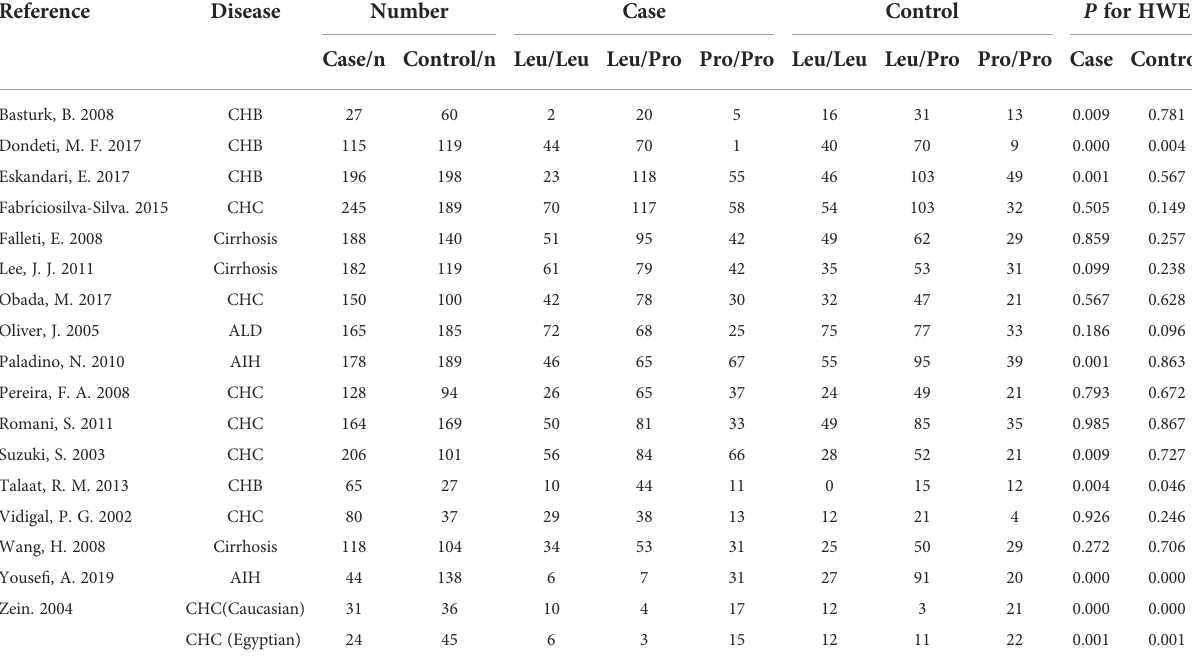
TABLE 3 The genotype and allele frequencies of TGF- b 1 codon 10 distribution of included